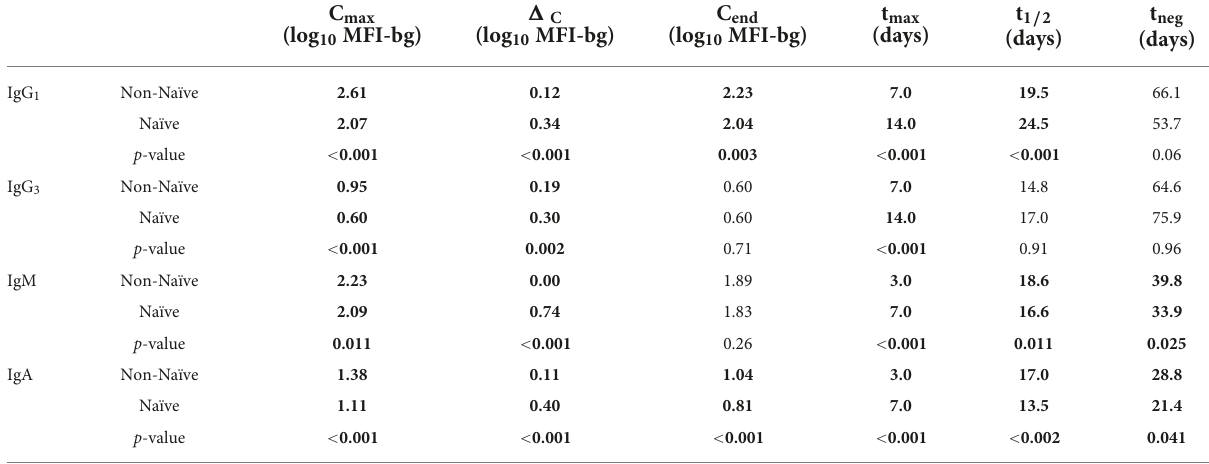
TABLE 2 Mean values for each parameter by immunoglobulin isotype/subclass as aggregate for all P. falciparum antigen responses estimated for the naïve and non-naïve